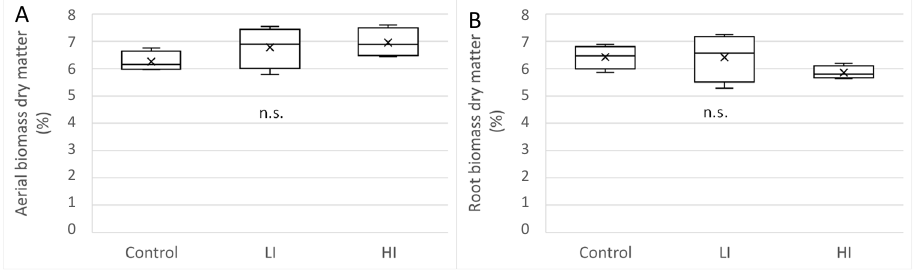
Figure 4. Effect of non-thermal plasma treatment on the dry matter concentration in the aerial biomass ( A ) and below-ground biomass ( B ) of lettuce. Within each parameter, values with different letters are significantly different at p < 0.05 based on the Tukey HSD test; LI = low ionization intensity; HI = high ionization intensity; n.s. = not significant.